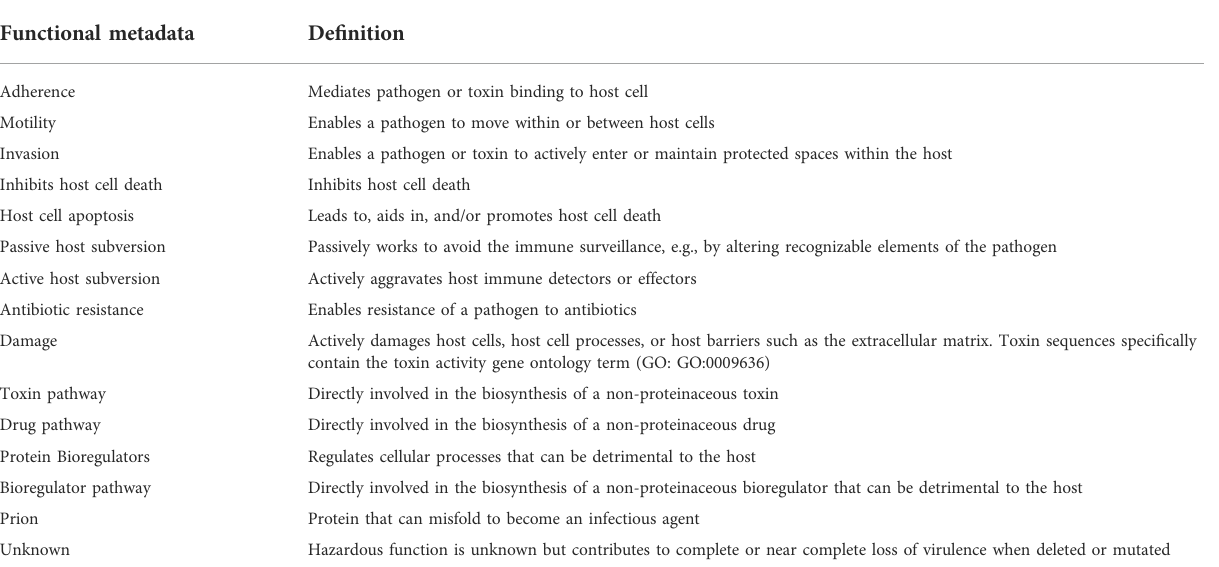
TABLE 1 Hazardous functional metadata